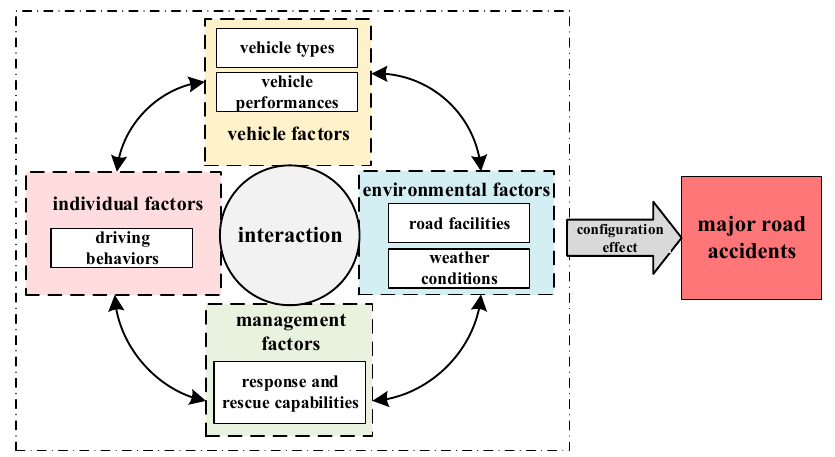
Figure 1. The analysis mode of the configuration effect for major road accidents.